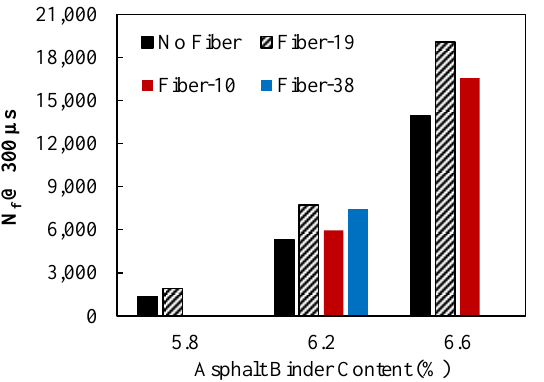
Figure 7. Uniaxial fatigue test results at different asphalt contents and fiber lengths.